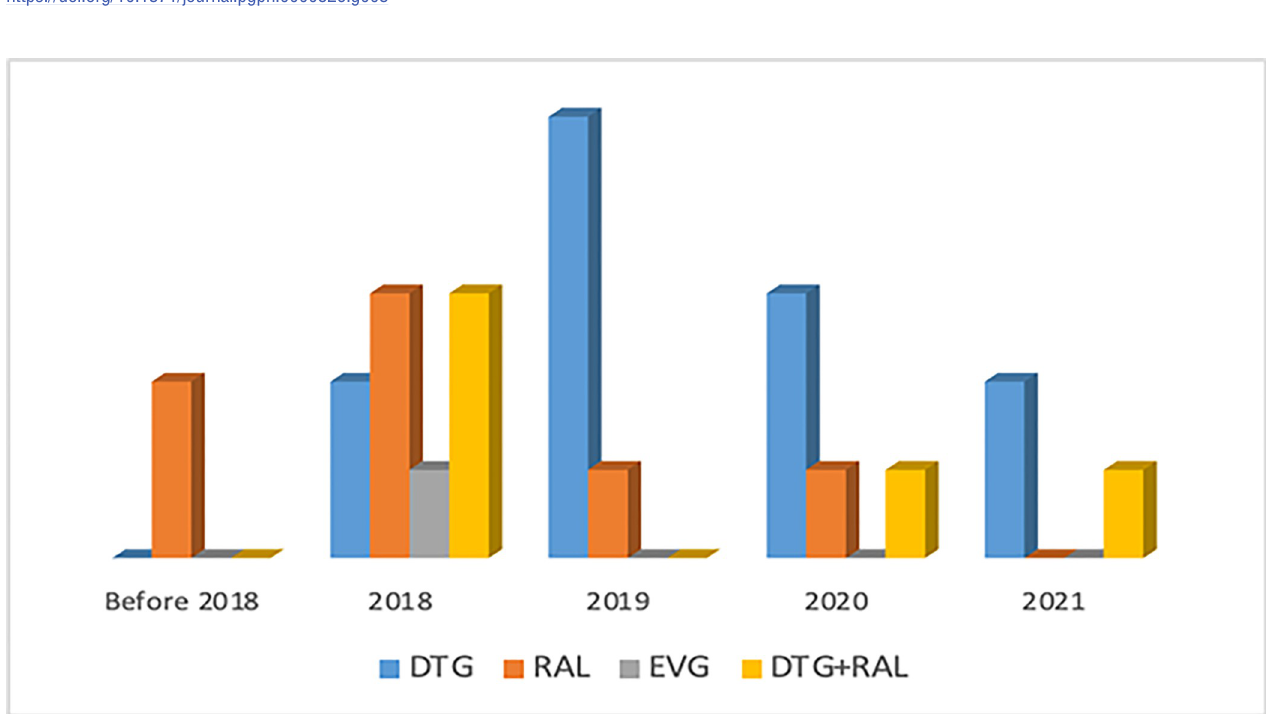
Fig 4. The figure portrays the use of dolutegravir in sub-Saharan Africa overtime.